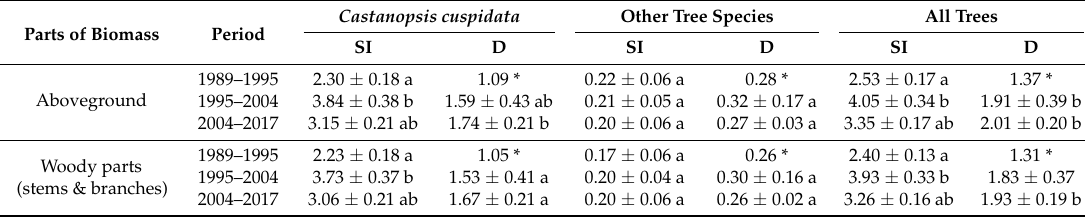
Table 4. Annual aboveground biomass and wood parts increments (SI) and losses (D) during each